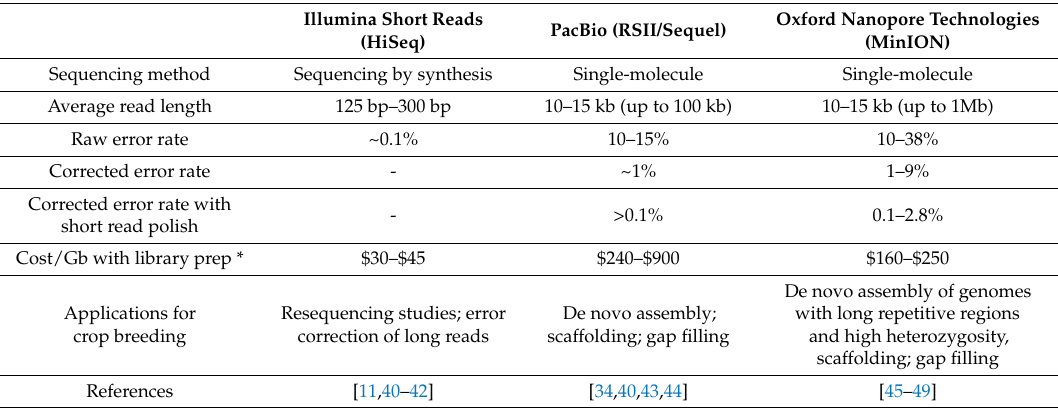
Table 1. Comparison of the three main sequencing technologies for crop genomics. Corrected error rates are calculated after applying error correction methods that do not require additional data. Prices are in